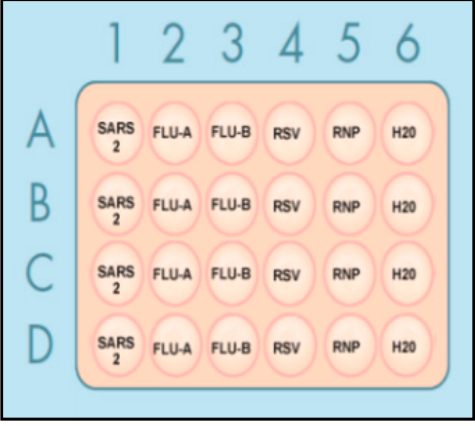
Figure 2. The RT-RPA mix was loaded in a 24-well plate. A 10 µl reaction containing a primer set for each target, RNA, and reverse transcriptase was added in each well in quadruplicate. Abbreviations: SARS 2 = SARS-CoV-2; FLU = influenza; and RNP = RNase P gene.